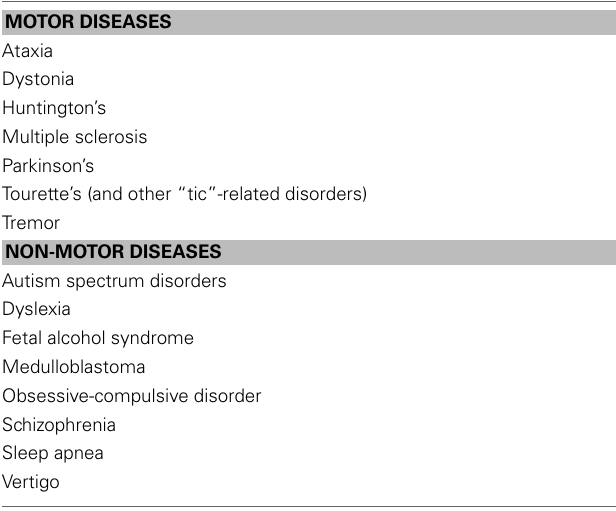
Table 1 | Cerebellar dysfunction contributes to motor and non-motor